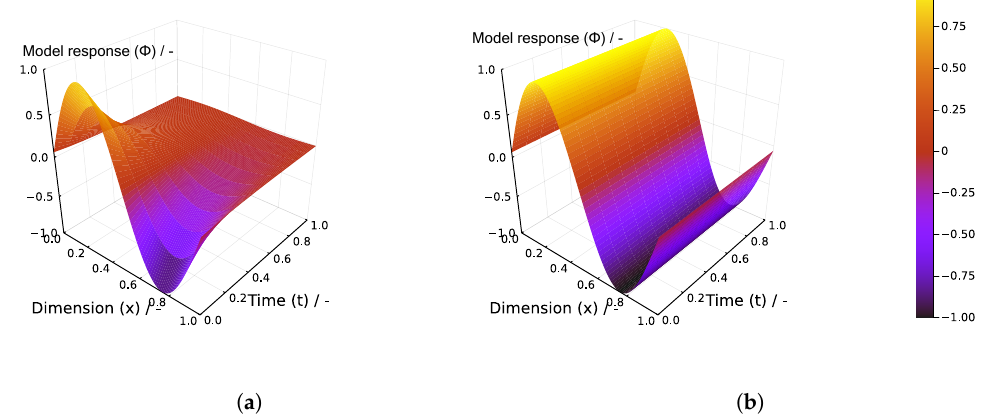
Figure 5. Model response for Scenario 1 assuming a distributed control problem with ( a ) when a zero input profile is applied (i.e., no control action that could counteract the diffusion effect) and with ( b ) when a purpose designed input is used to cancel out the diffusion effect; adapted from